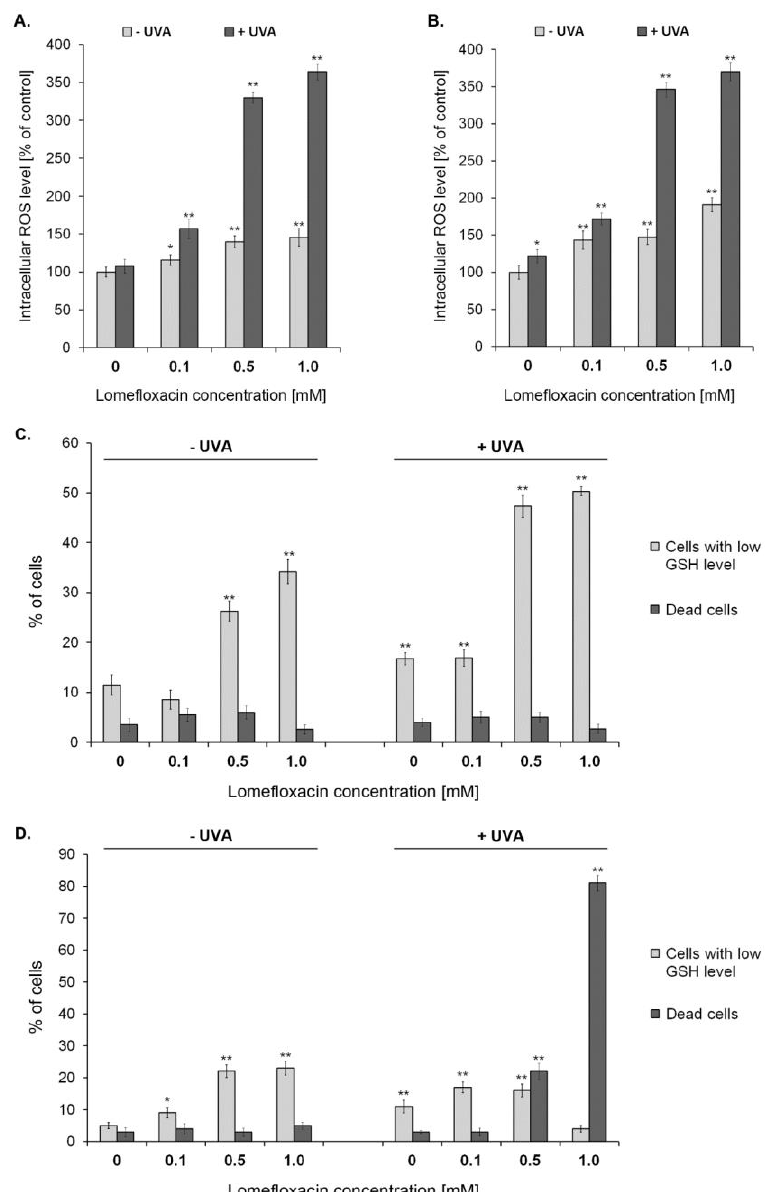
Figure 3. UVA radiation-intensified lomefloxacin induces ROS production in amelanotic C32 ( A ) and melanotic COLO829 ( B ) melanoma cells. The cells were pre-treated with lomefloxacin at concentrations of 0.1, 0.5, and 1.0 mM alone for 24 h or exposed to the drug and UVA irradiation (1.3 J/cm 2 ). The data are expressed as percentages of the controls normalised to a number of living cells. Mean values ± SEM from three independent experiments ( n = 9) performed in triplicate are presented. * p < 0.05, ** p < 0.005 vs. control samples. Co-treatment of C32 ( C ) and COLO829 ( D ) melanoma cells with lomefloxacin and UVA irradiation augments cellular GSH depletion. The cells were pre-treated with lomefloxacin at concentrations of 0.1, 0.5, and 1.0 mM alone for 24 h or exposed to the drug and UVA irradiation (1.3 J/cm 2 ). Mean values ± SEM from three independent experiments ( n = 9) performed in triplicate are presented. ** p < 0.005 vs. control samples. Representative histograms are available in the Supplementary Materials S1.